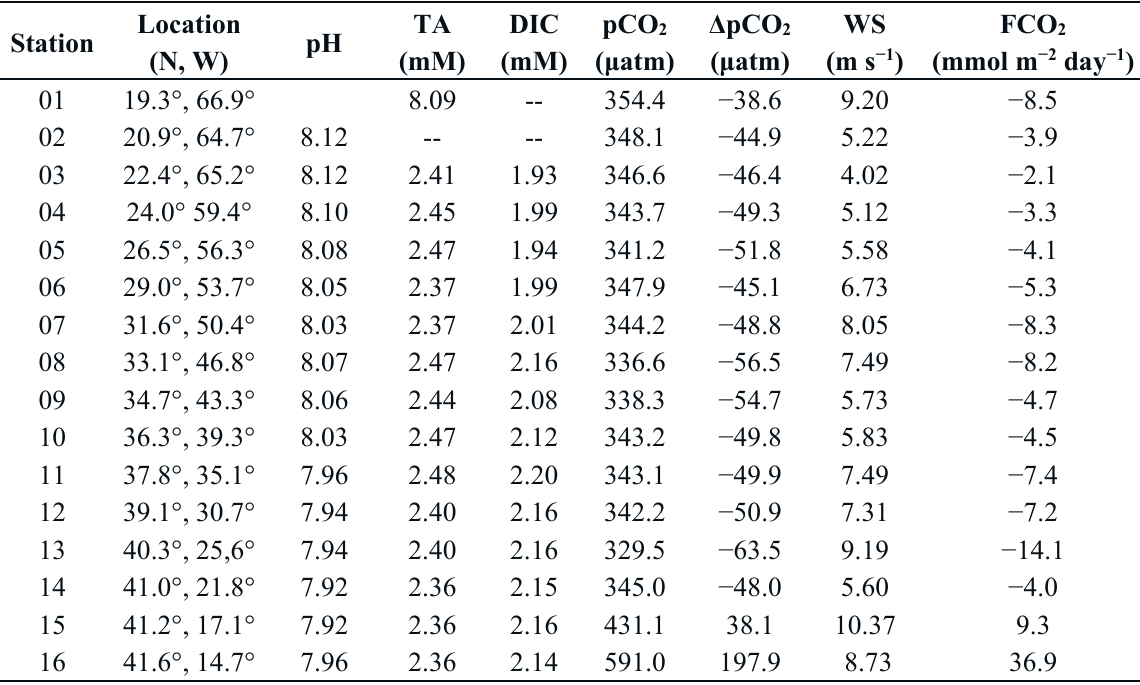
Table 1. Sampling station location and daily mean values of sea surface pH, total alkalinity (TA), dissolved inorganic carbon (DIC), partial pressure of CO 2 (pCO 2 ),